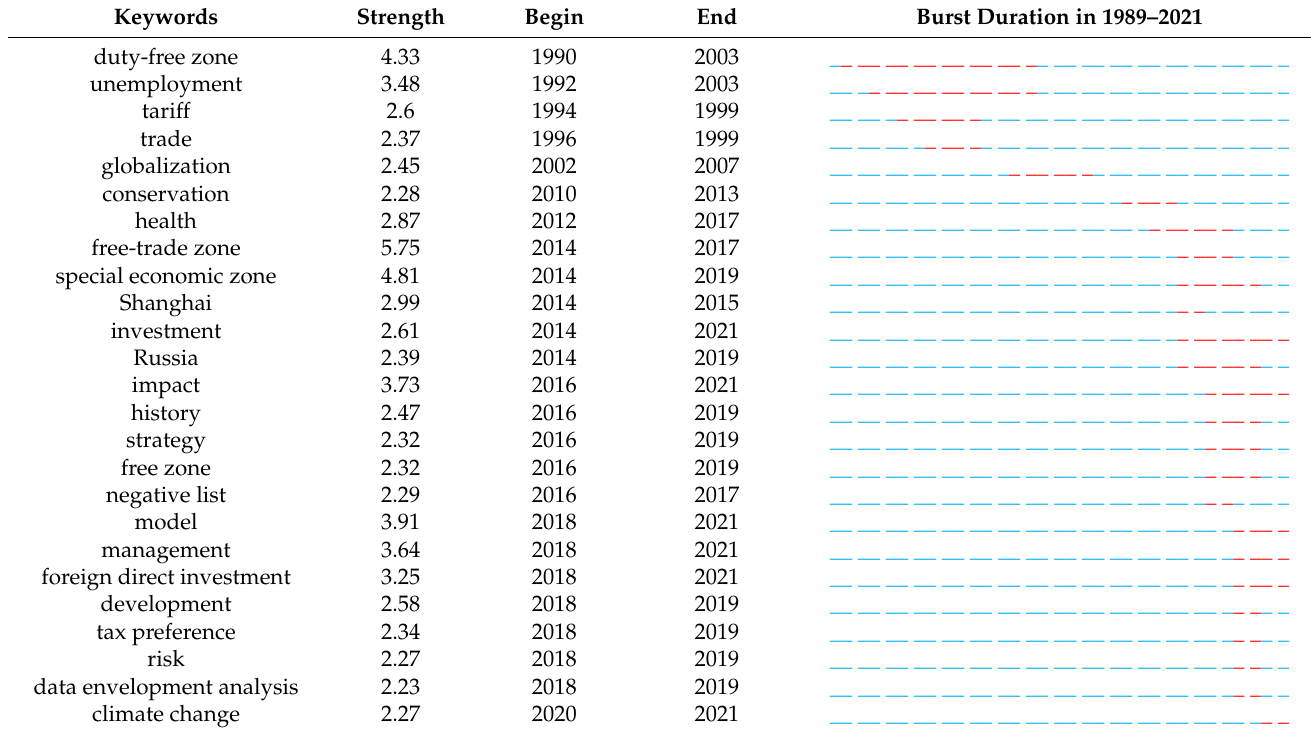
Table 6. Top 25 keywords with the strongest citation